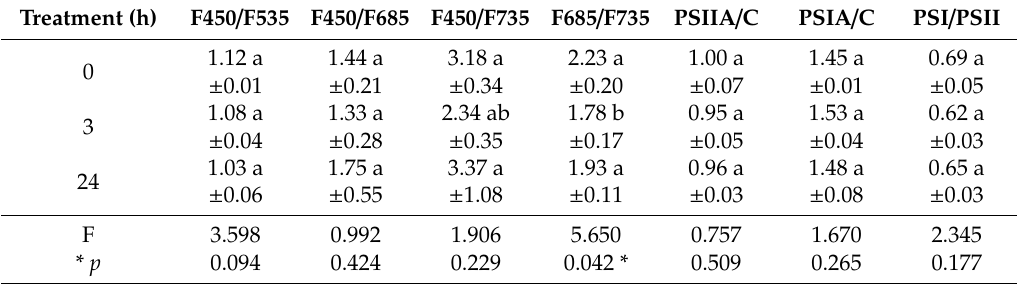
Table 4. Fluorescence emission indexes of triticale ( × Triticosecale Wittm. ex A.Camus) plants grown 3 and 24 h; mean ± SD (n = 10) values marked with di ff erent letters di ff er statistically according to Tukey’s test at * p ≤